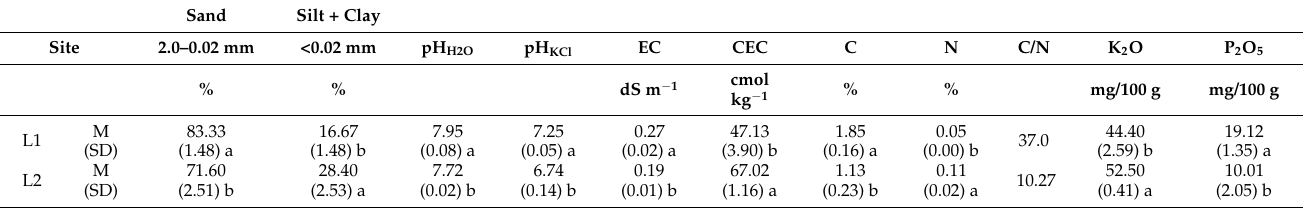
Table 1. Selected physical and chemical properties of the surface layer (0–30 cm) of fly ash from the examined sites (L1 and